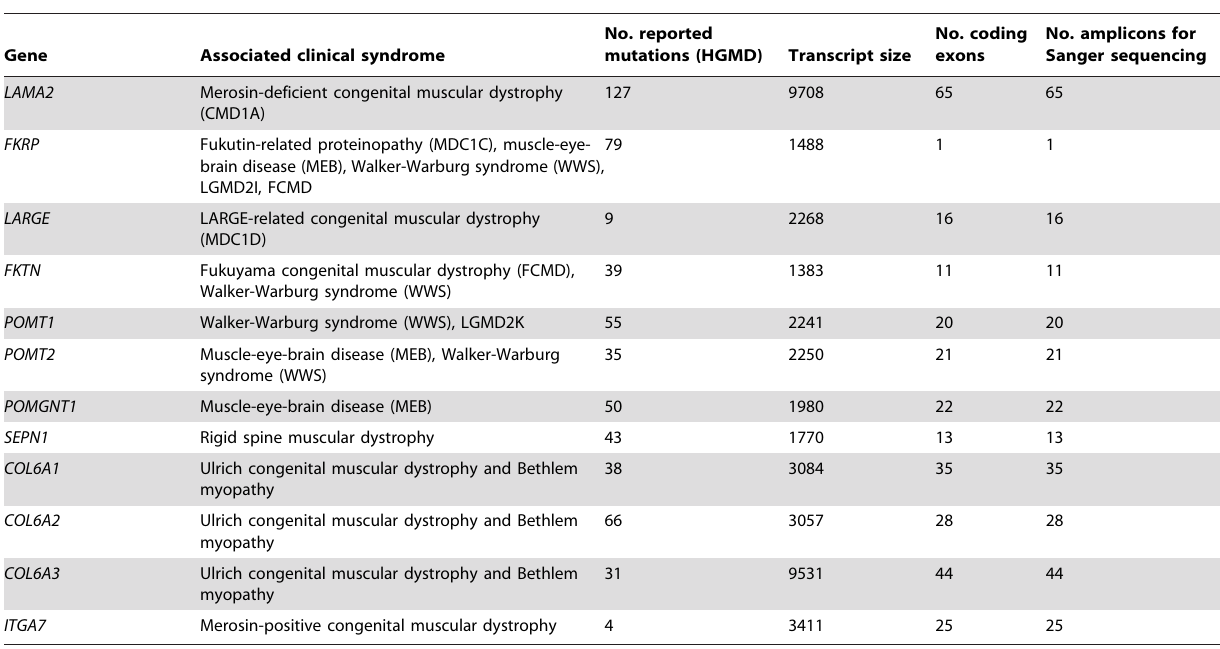
Table 2. CMD-associated genes included in the clinical CMD NGS panel.